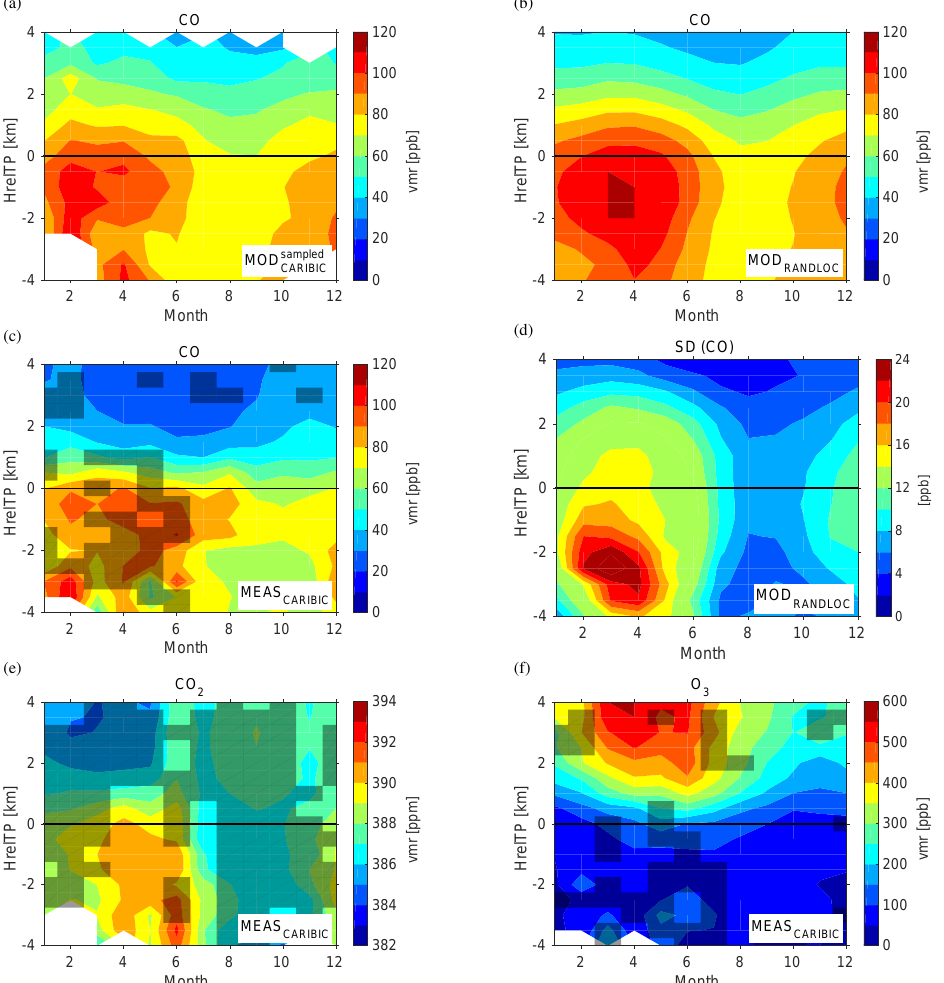
Figure 10. Climatology of CO, built from MOD sampled (a) , MOD RANDLOC (b) and the CARIBIC measurements (MEAS CARIBIC , c ). CARIBIC Areas of 10 R rel > 0 . 1, calculated from the top row, were used to shade non-representative areas in the climatology of MEAS CARIBIC in grey. Panel (d) displays the 1 σ standard deviation of CO from MOD RANDLOC . The bottom row (e, f) displays climatologies from MEAS CARIBIC of CO 2 (left) and O 3 , shaded with 10 R rel > 0 . 003 and 10 R rel > 0 . 15,